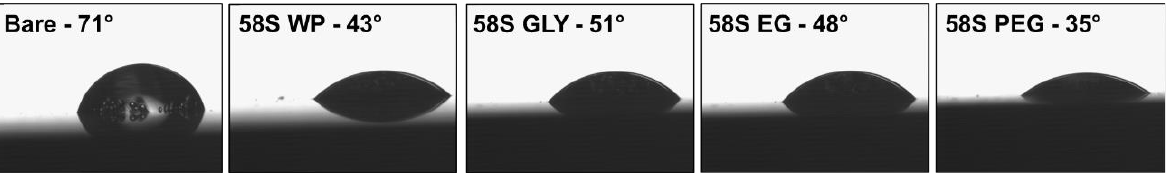
Figure 3. FT-IR spectra of 58S WP, 58S GLY, 58S EG, and 58S PEG sols heat-treated at 160 ◦ C/1 h.